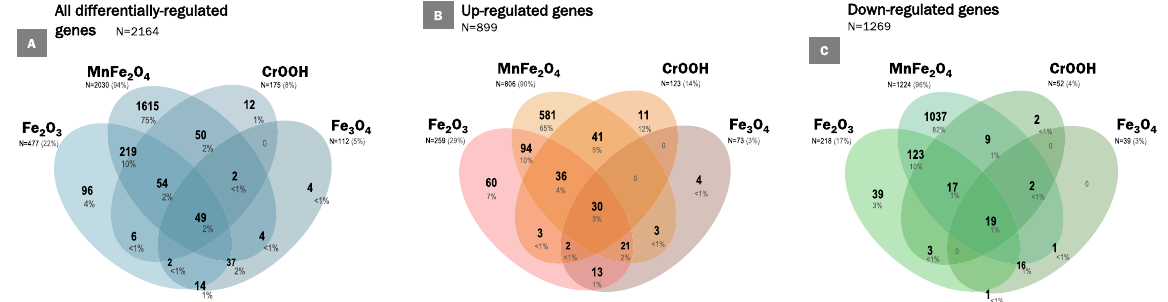
Figure 2. Venn diagrams of differentially expressed genes (N = 2164). Venn diagram of unique and shared genes among the four nanoparticles: ( A ) All differentially expressed genes, ( B ) Up-regulated genes and ( C ) Down-regulated genes. Abbreviations as in Fig.